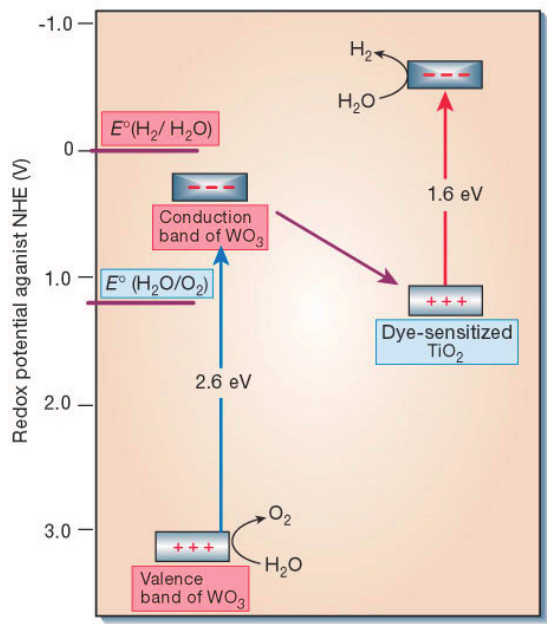
Figure 16. Example of Z-scheme (4D): WO 3 photoanode (E cb < E° H+ / H2 ) coupled to dye-sensitized TiO 2 (reproduced from [76] with permission of the Nature Publishing Group).